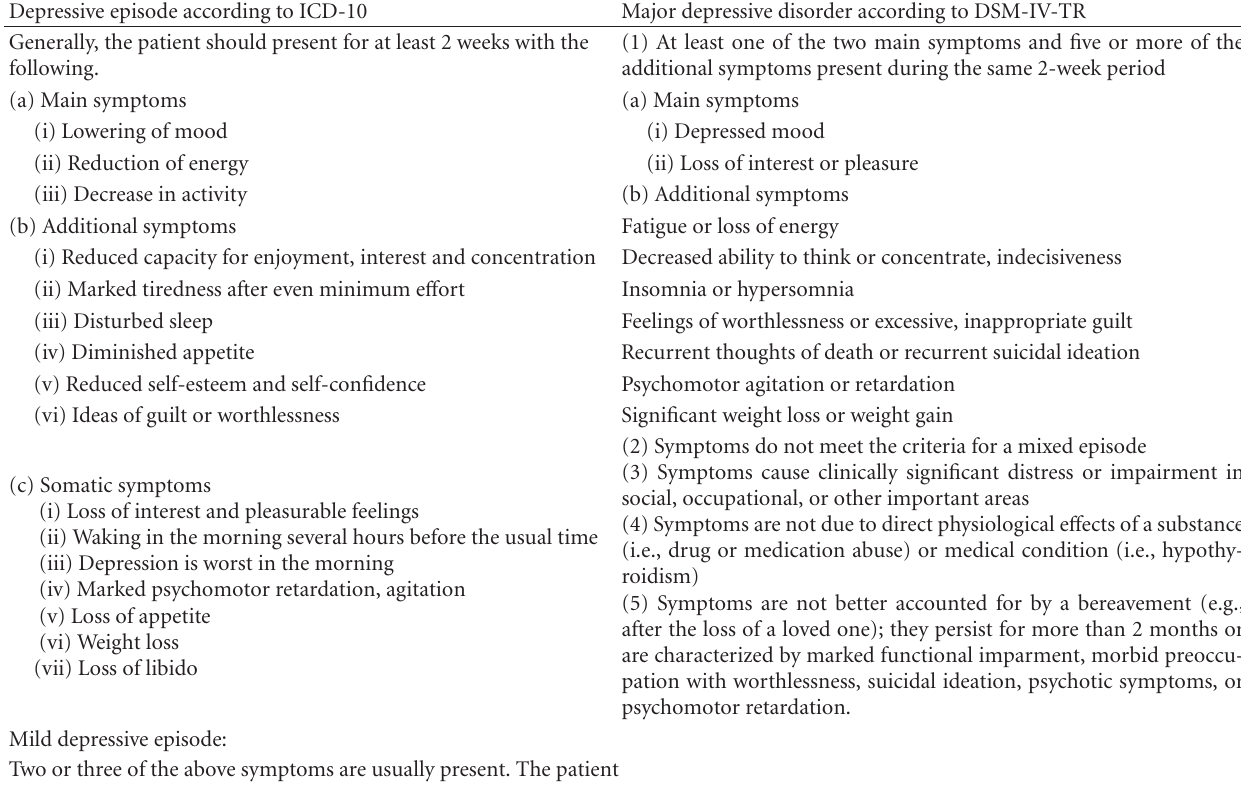
Table 1: ICD-10 (version 2010) and DSM-IV-TR criteria for